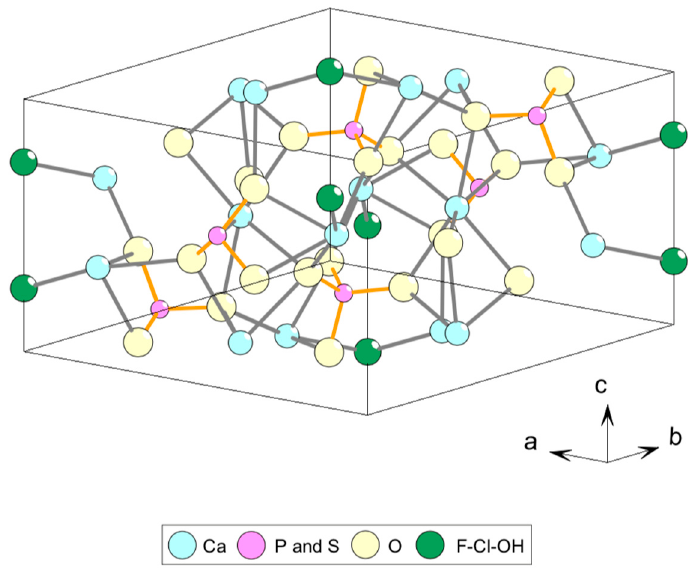
Figure 1. Optimised crystal structure of apatite.